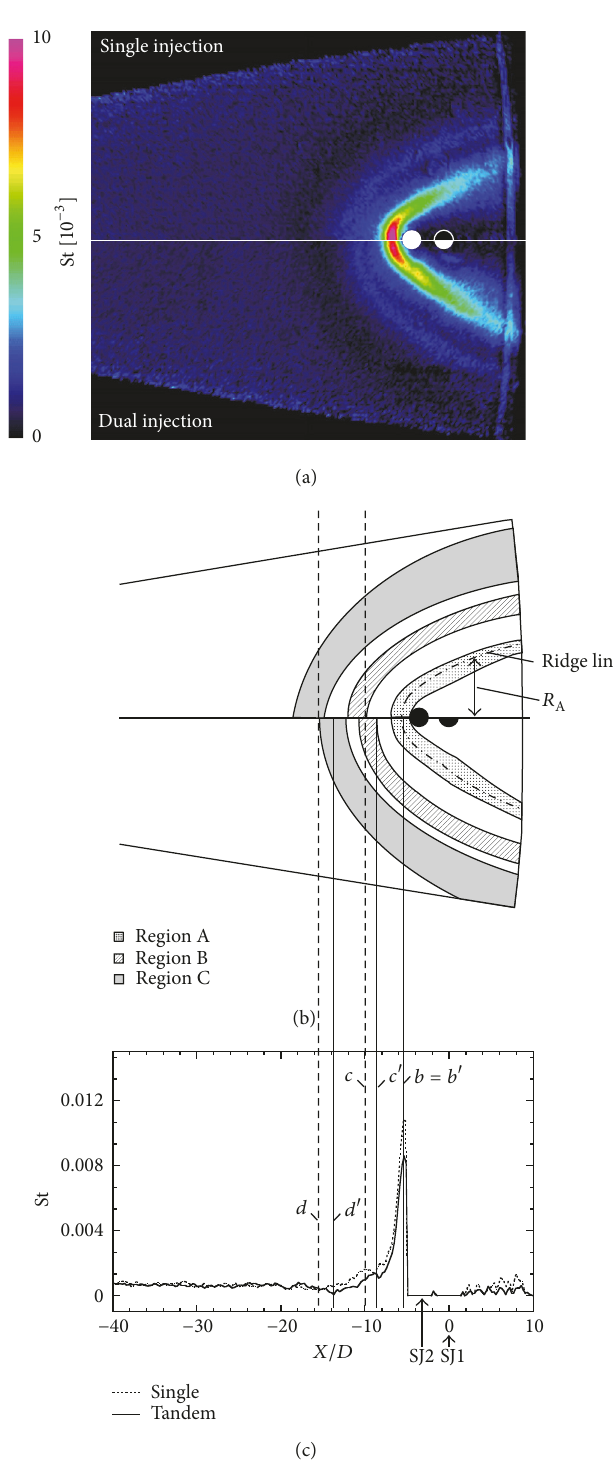
Figure 12: St distribution in the tandem configuration for 𝑆 𝑥 /𝐷 = 3.36 . (a) Surface distribution of Stanton number measured by TSP, (b) schematic of the heating patterns, and (c) one-dimensional profile of on the 𝑥 -axis, with single and tandem dual injection at 𝑆 𝑥 = 3.36𝐷 . Point b , locus with peak Stanton number; point c , peak of separation vortex; and point d , separation point. Prime marks indicate the points with dual injections. The upper half of (a) and (b) displays a single injection case and the lower half a dual injection